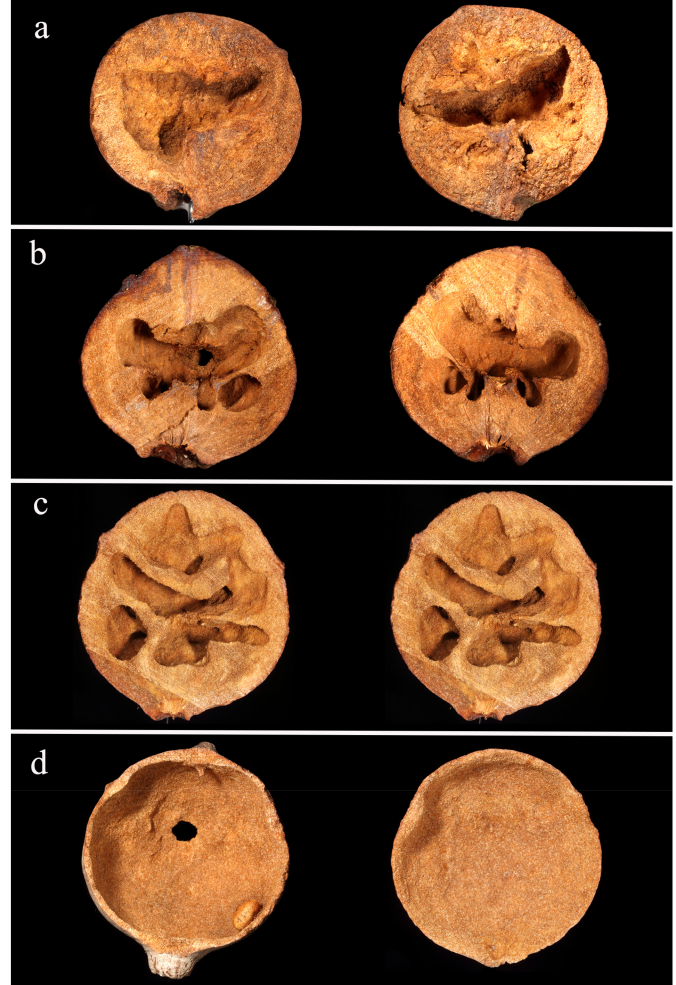
Figure 6. Inner architecture of a gall colonized by Cr. scutellaris . The e ff ect of di ff erent colony composition is shown: queen only ( a ), queen + workers + brood ( b ), workers + brood ( c ), workers only ( d ). In ( d ), the puparium of the cynipid wasp is still